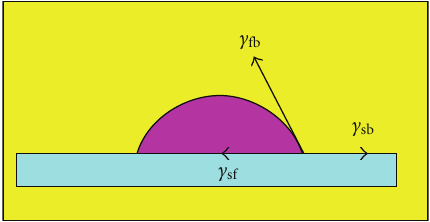
Figure 2: Shows interfacial tensions working on a macroscopic drop at a substrate. γ fb , γ sf , and γ sb are interfacial tensions between fluid-bounding medium, surface-fluid medium, and surface-bounding medium.